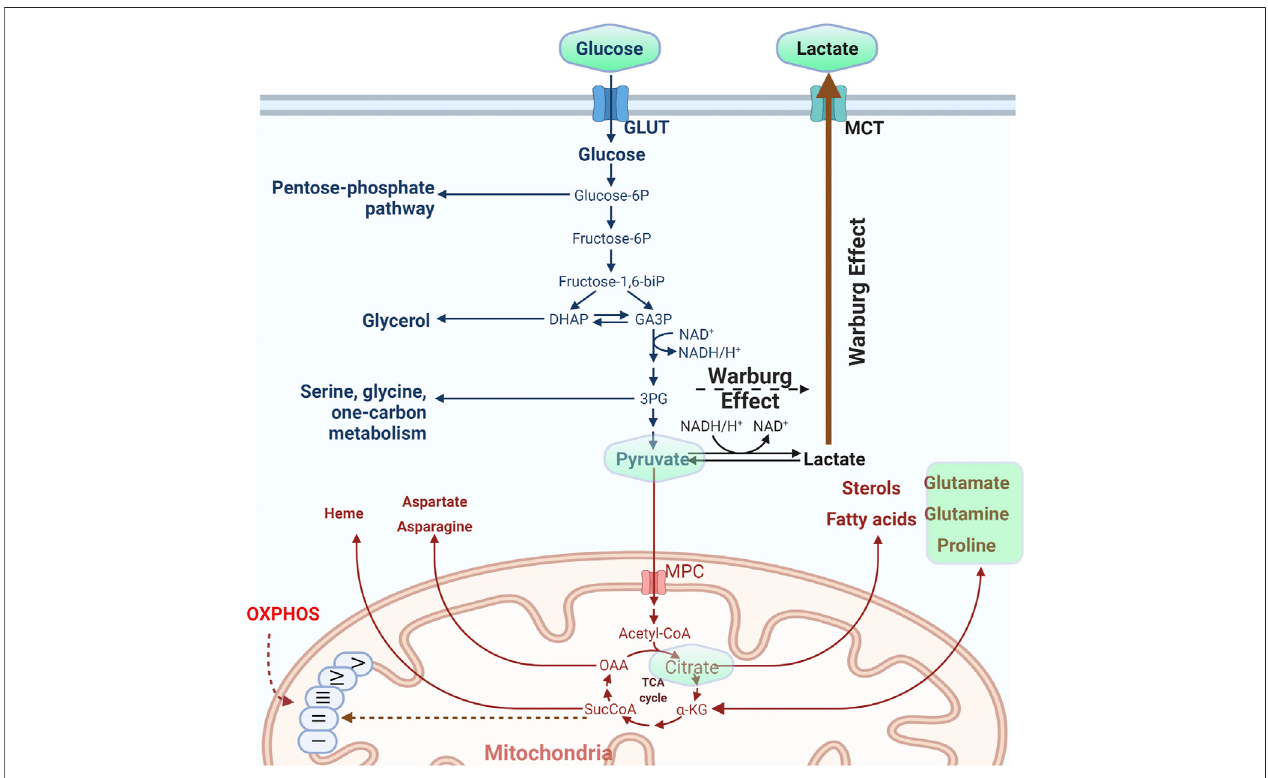
FIGURE 1 | Outline of the basic metabolic pathway of glucose. The molecule is imported inside the cells and depending on the metabolic status might be used eitherforthesynthesisofnitrogenbasesthroughthepentosephosphate pathwayorconverted totriosesandfromtheretopyruvate.Thelastmetabolitemayeitherfeed mitochondriaorbeconvertedtolactateandsecretedintheextracellularmedium.Highrateofpyruvateconversiontolactatedespitethepresenceofoxygeniscalledthe “ Warburgeffect. ” Forsomeofthemetabolitesdepictedinthe fi gure,existing fl uorescentreportersaredescribedinthemaintext.Thosemetabolitesareembedded in a light green frame. (Figure prepared by modifying a Biorender.com